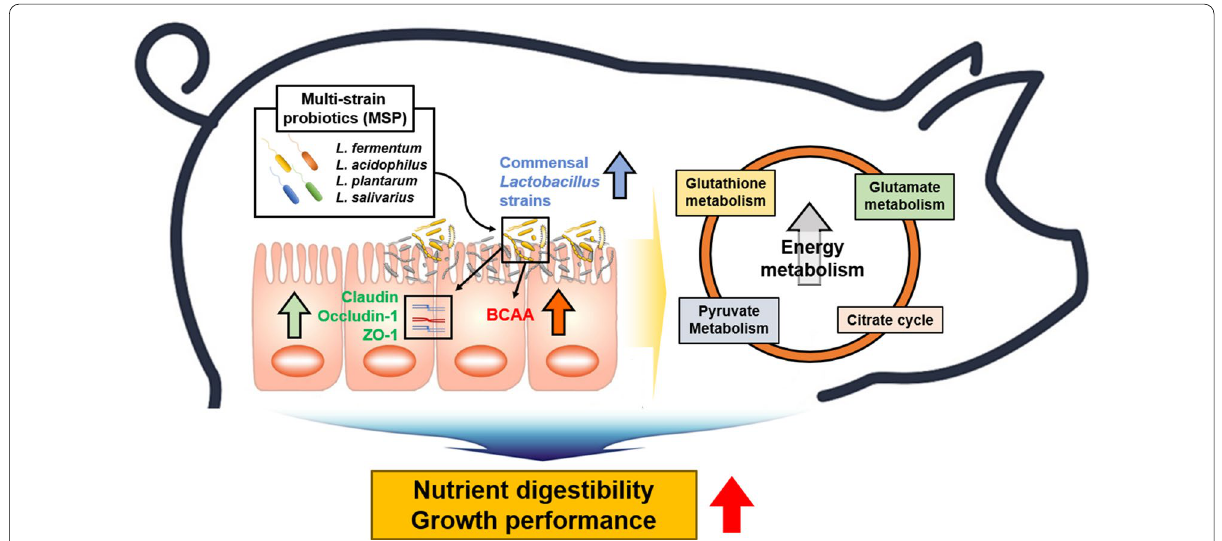
Fig. 8 Schematic diagram. Schematic showing the results of integrated metagenomic, culturomics, and metabolomic analyses of the beneficial roles of MSP in weaning pigs. MSP increased the relative abundance of commensal Lactobacillus strains as well as improvement of BCAA production and energy metabolism. Furthermore, enhanced concentration of BCAA coupled with intestinal mucosal barrier integrity are considered to benefit piglets digest nutrients more efficiently, resulting in improved growth